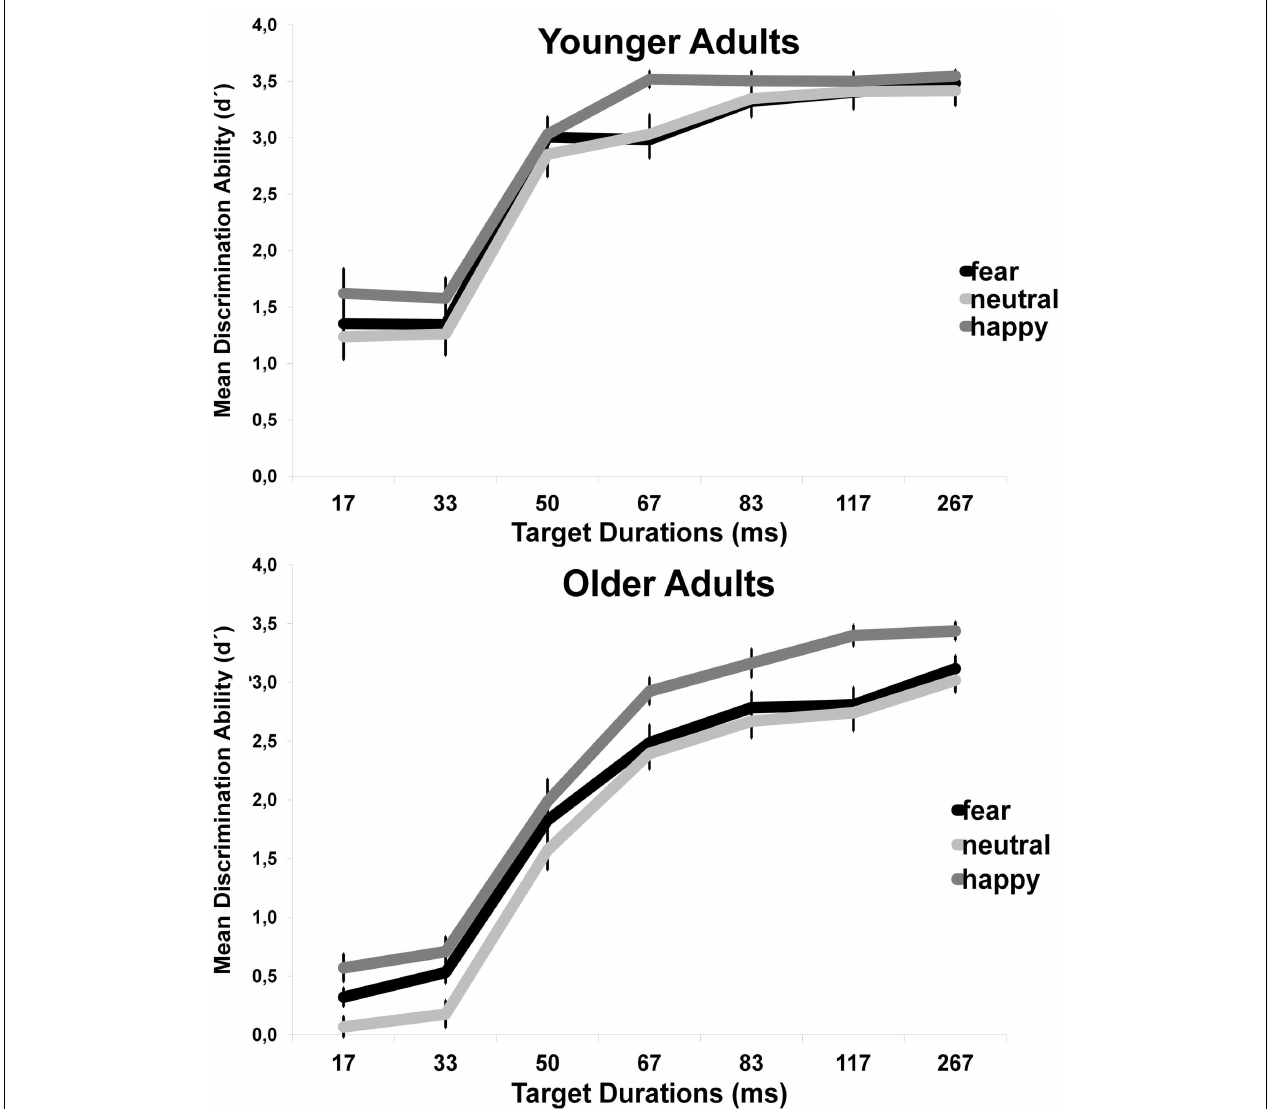
FIGURE 3 | Mean (SE) recognition performance ( d (cid:48) ) in the masked recognition task depending on picture duration, facial emotion and age.